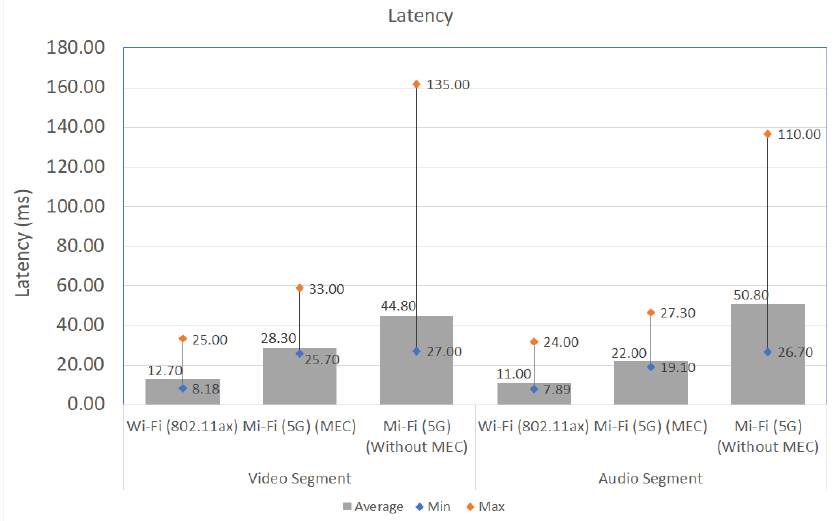
Figure 10. Schemes follow the same formatting.